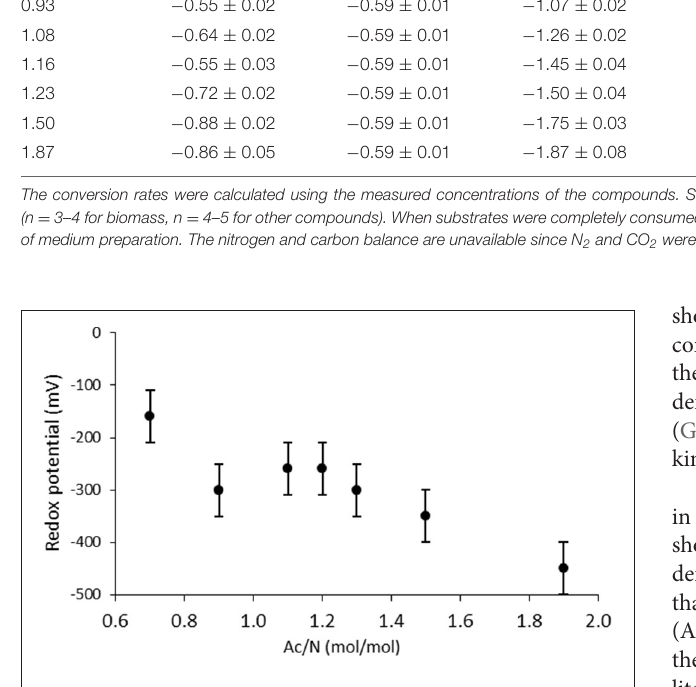
FIGURE 2 | Redox potential measured in the culture at different Ac/N ratios. A linear correlation could be observed.